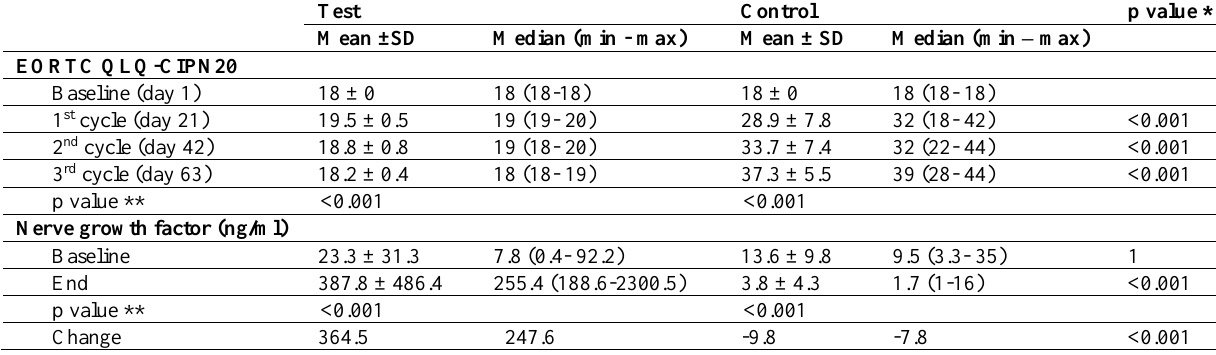
Table 2: EORTC QLQ-CIPN20 neuroscores and nerve growth factor levels in both groups